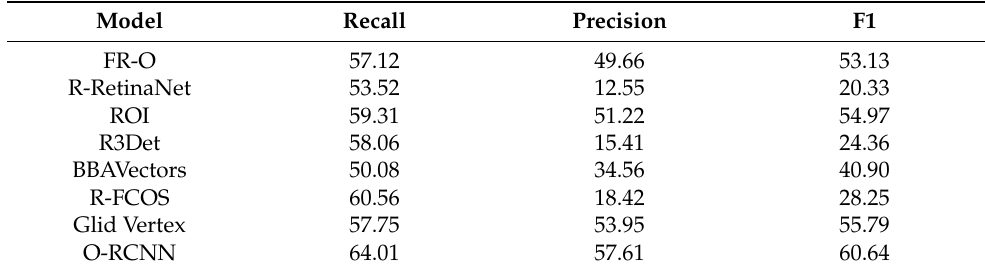
Table 5. The results of recall, precision, and F1 on the test set.